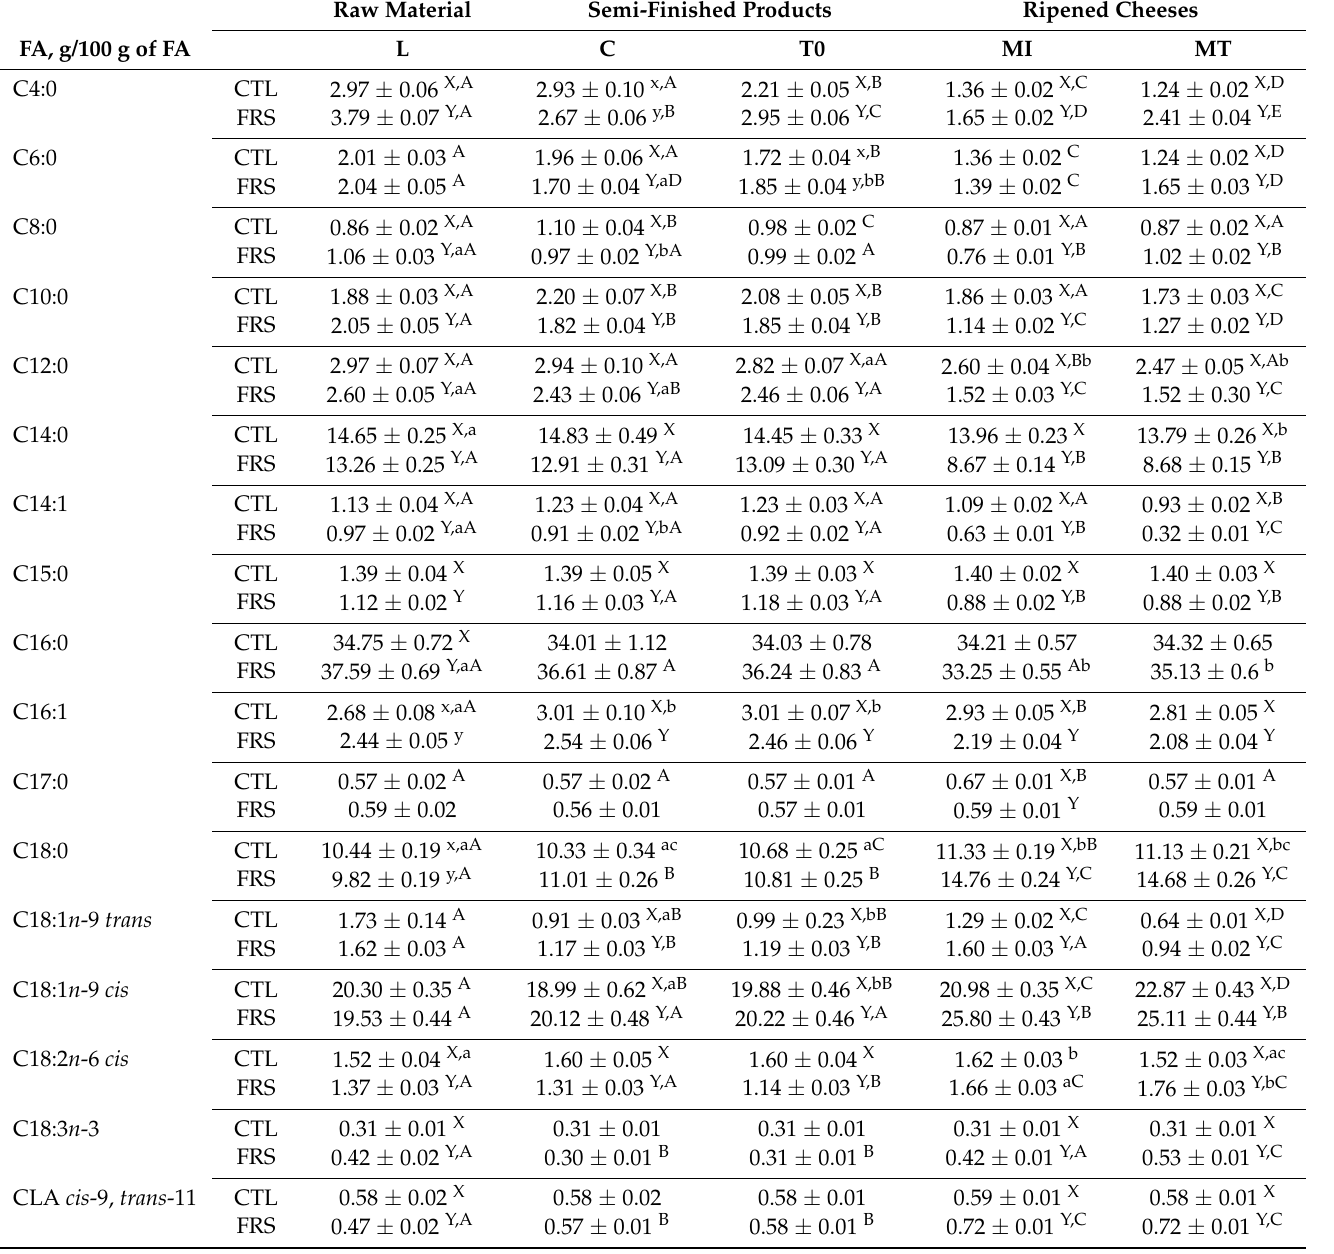
Table 6. Effects of feeding system and ripening time on fatty acid profile of semi-hard cheeses. Raw